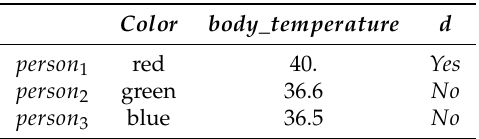
Table 1. The exemplary decision system ( U , A , d )